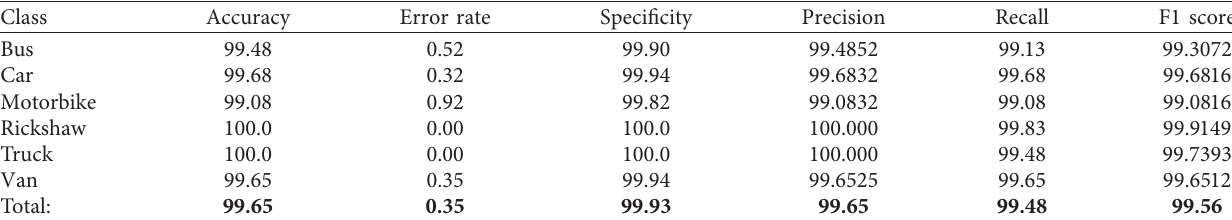
Table 4: Performance metrics of proposed system on self-constructed dataset.